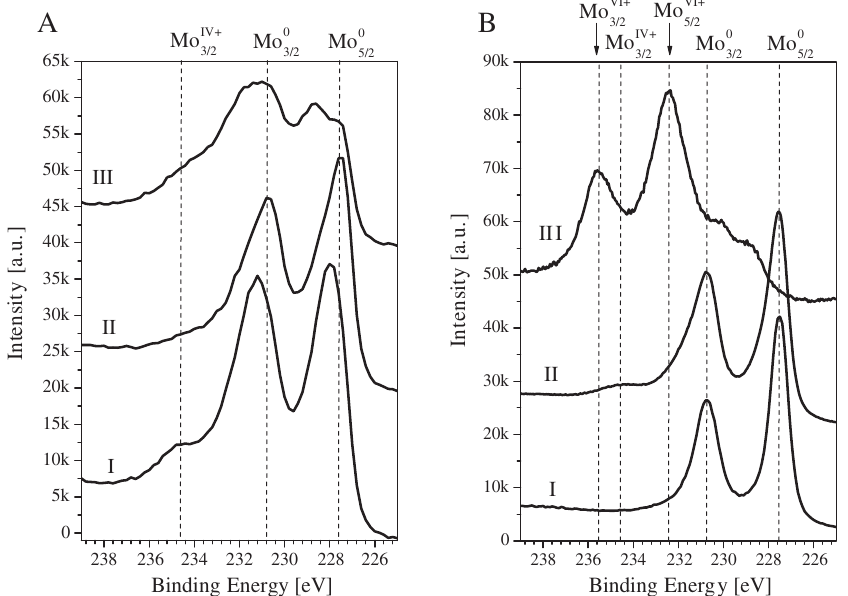
FIG. 4. Mo 3 d photoemission spectra. (A) Molybdenum surface after sputter cleaning with Kr (cid:3) ion, plus 1 h exposure of atmospheric air. (I) Surface area unaffected by breakdown conditioning. (II) UHV breakdown conditioned area, (III) Area affected . (B) Reference molybdenum sample. (I) Ar (cid:3) sputter cleaned by breakdown conditioning during exposure of (cid:1) 2 (cid:6) 10 (cid:2) 6 mbar O 2 molybdenum surface. (II) Sample (I), followed by a 1 h exposure of atmospheric air. (III) Virgin molybdenum surface. All spectra are normalized to equal ‘‘peak-to-background’’ height relative to the most intense Mo 3 d 5 = 2 peaks for